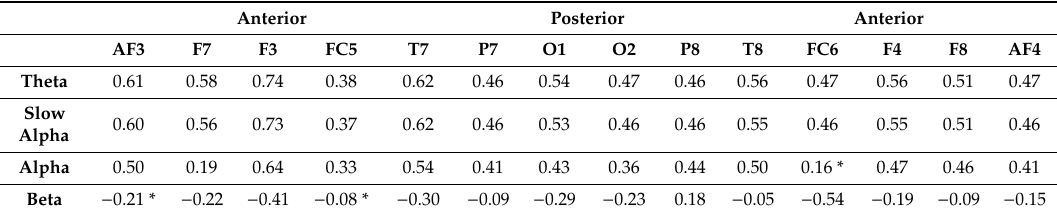
Table A2. Correlation between EEG PSD frequency bands and ground truth after triggered by video contents where the significant correlation ( p value ≤ 0.05) is indicated with